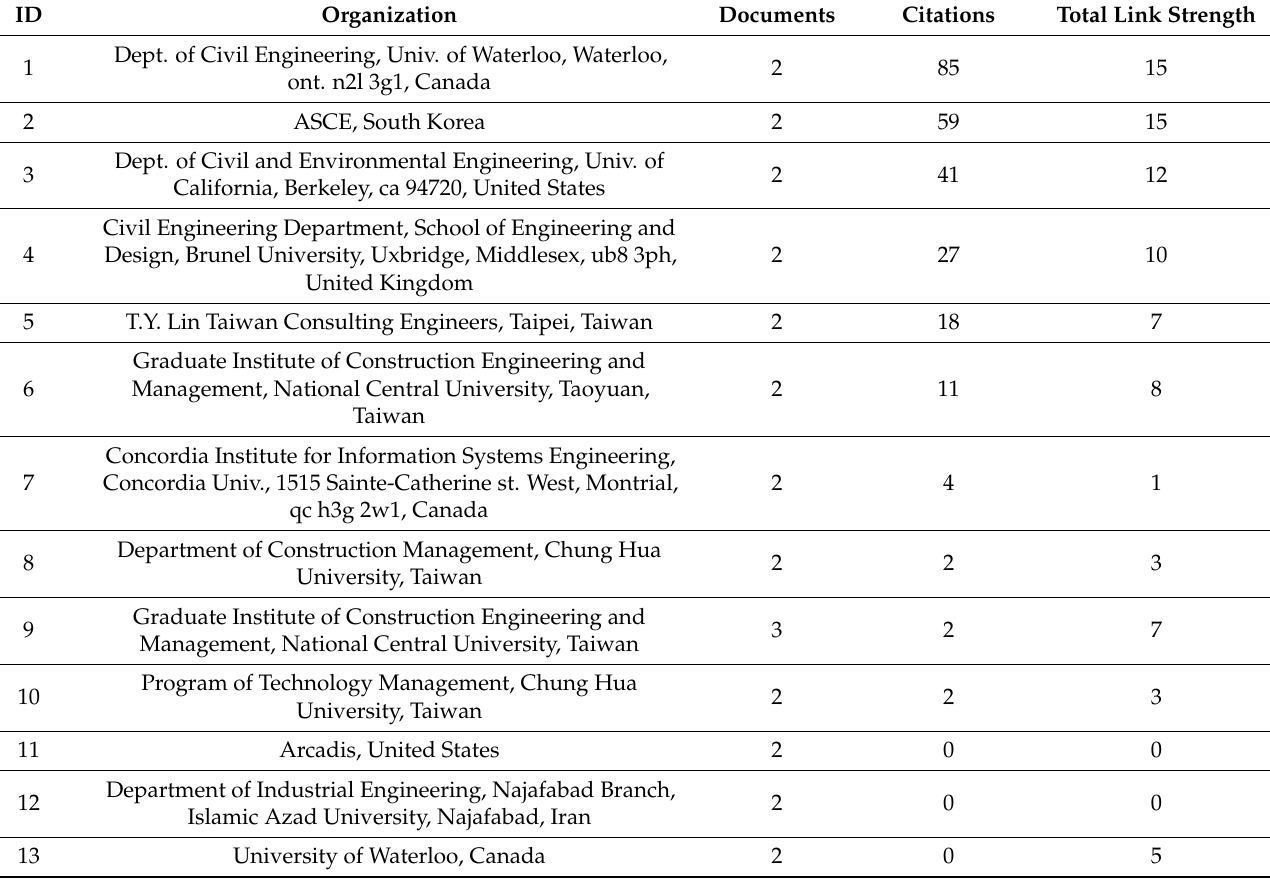
Table 5. Organizations publishing documents related to delay analysis subject.